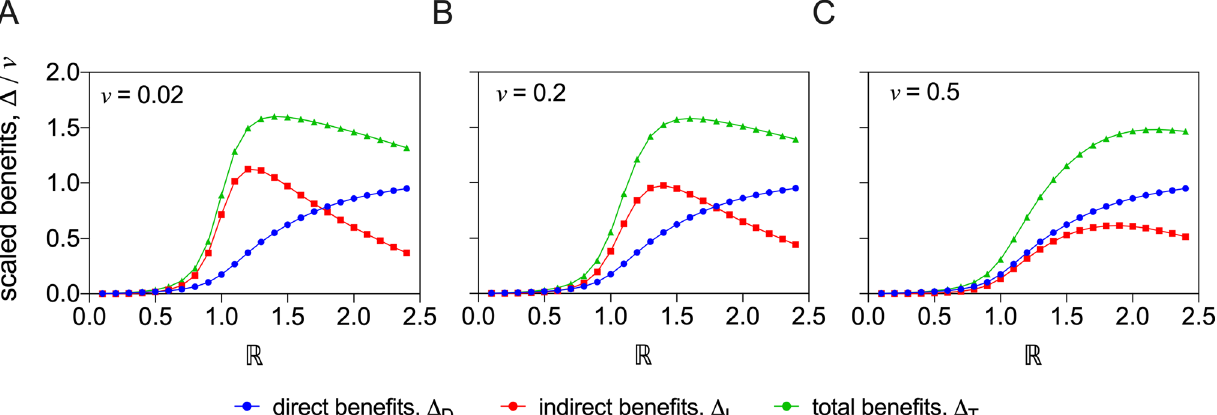
Figure 2. Benefits of vaccination. The direct, indirect and total benefits are plotted as functions of the basic reproduction number, R . The effectiveness of the vaccine has been set to ε = 1.0 , and the vaccination rate, v , has been set to the values 0.02, 0.2 and 0.5 in Panels ( A – C ), respectively.